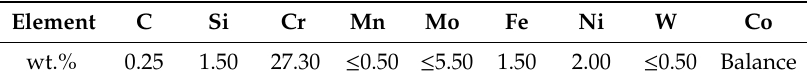
Table 1. Composition of the cobalt-based alloy